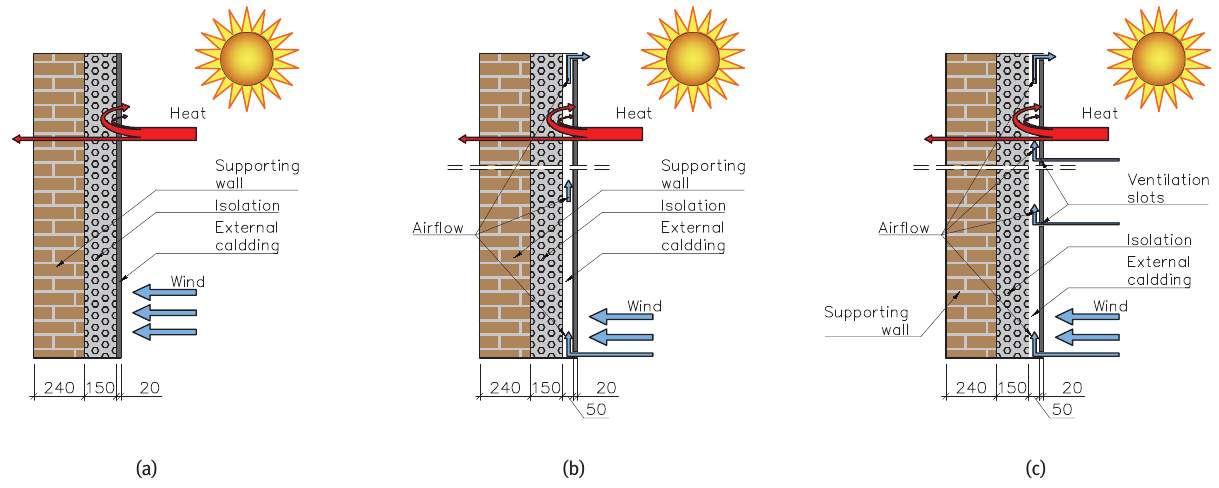
Figure 4: Facade diagrams for numerical simulations: (a) standard facade, (b) closed-joint ventilated facade and (c) open-joint ventilated